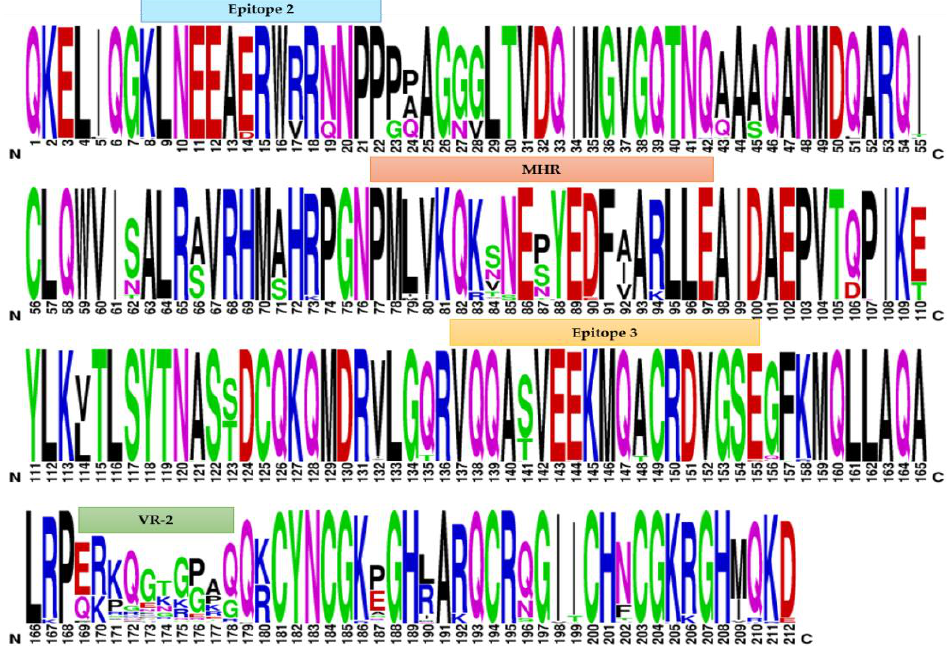
Figure 3. Graphical representation of the relative amino acid frequency of the partial SRLV gag-pol protein obtained by WebLogo 3 software. The height of the letter corresponding to each amino acid indicates its relative frequency at that specific position. Different colors indicate the physiochemical characteristics of the amino acid (black: non-polar, green: polar, red: aromatic, blue: positively charged, purple: negatively charged) .